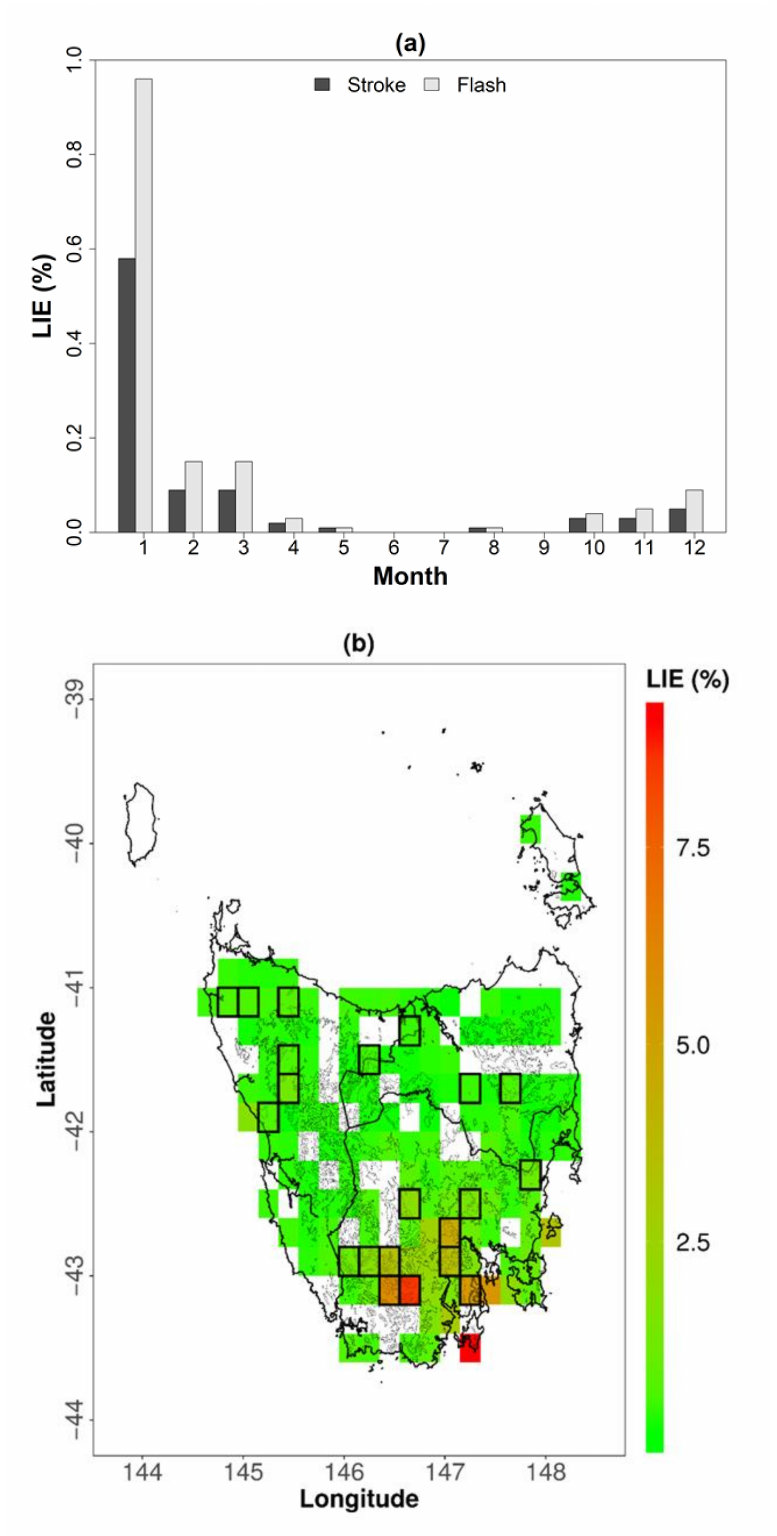
Figure 8. (a ) Lightning Ignition Efficiency (LIE) per lightning stroke and per lightning flash categorized by month. (b) Spatial variability of LIE (per stroke); Pixels with more than 4 lightning-induced fires over the study period are highlighted with a black square around the grid cells. The boundaries show the Natural Resource Management (NRM) regions North, North-West, and South